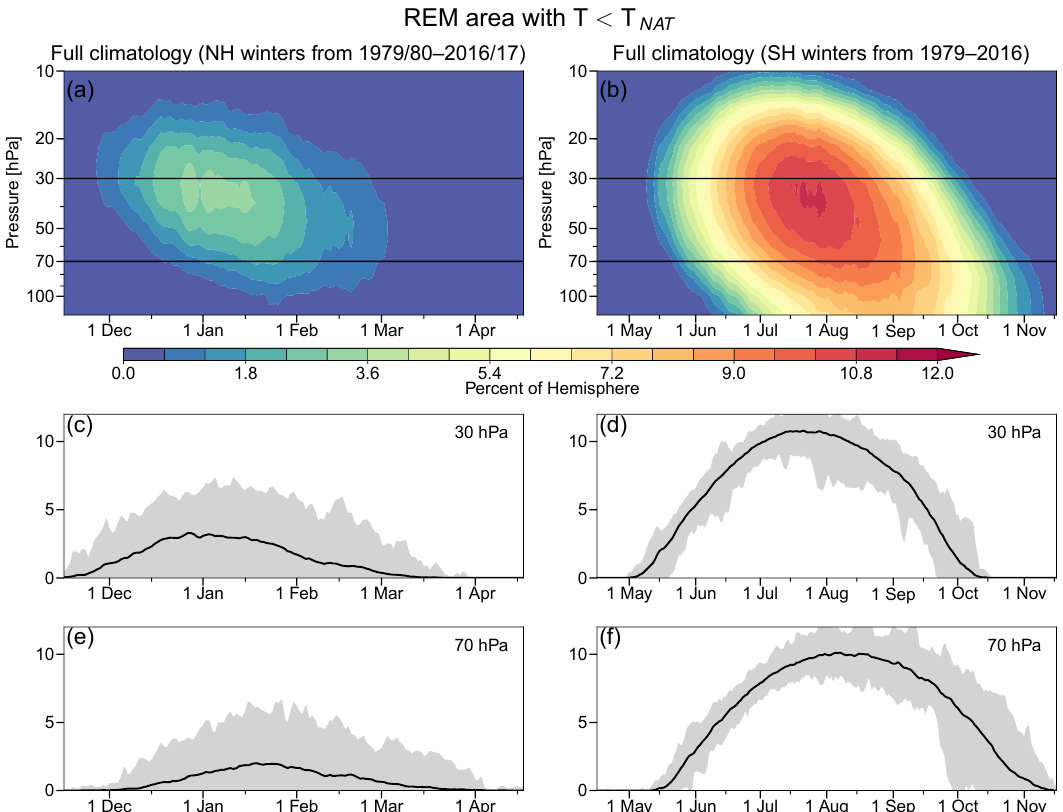
Figure 6. As in Fig. 3 but for area with temperatures below the NAT PSC threshold. The color range in panels (a) and (b) goes from 0% to 12% of a hemisphere (blues to reds), with all values above 12% shown in the deepest